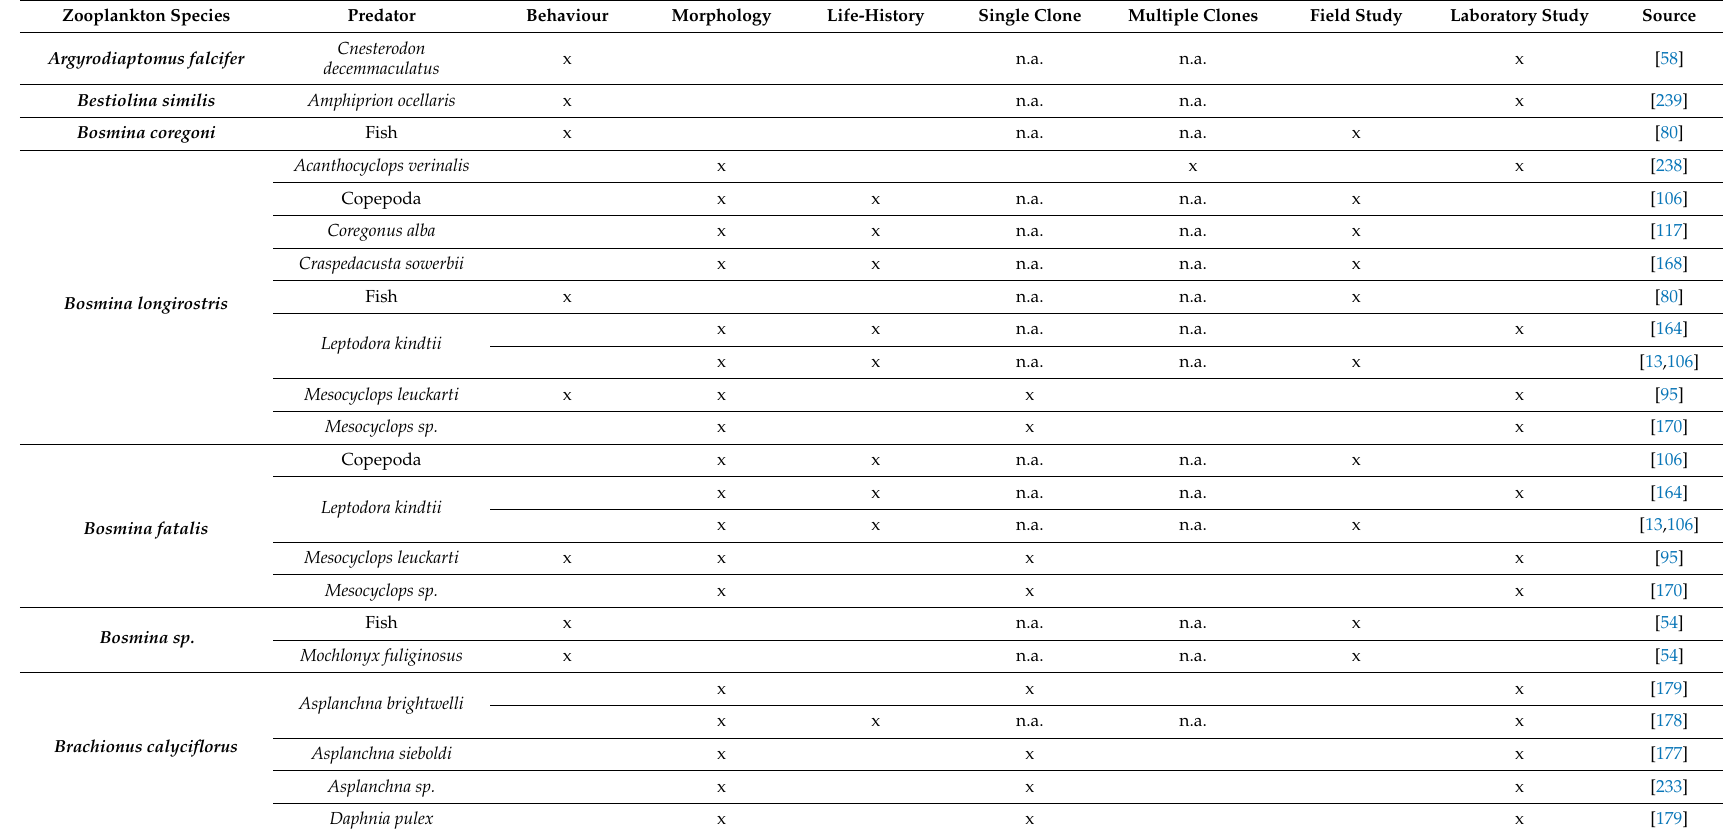
Table A1. Collection of studies completed since 2003 on inducible defences in zooplankton, each listed with their specific characteristics. Prey and predator species are specified to the level mentioned in the respective study. In cases of uncertainty, whether a single or a set of clones were used or where no clonal lineages were applicable, n.a. is quoted.